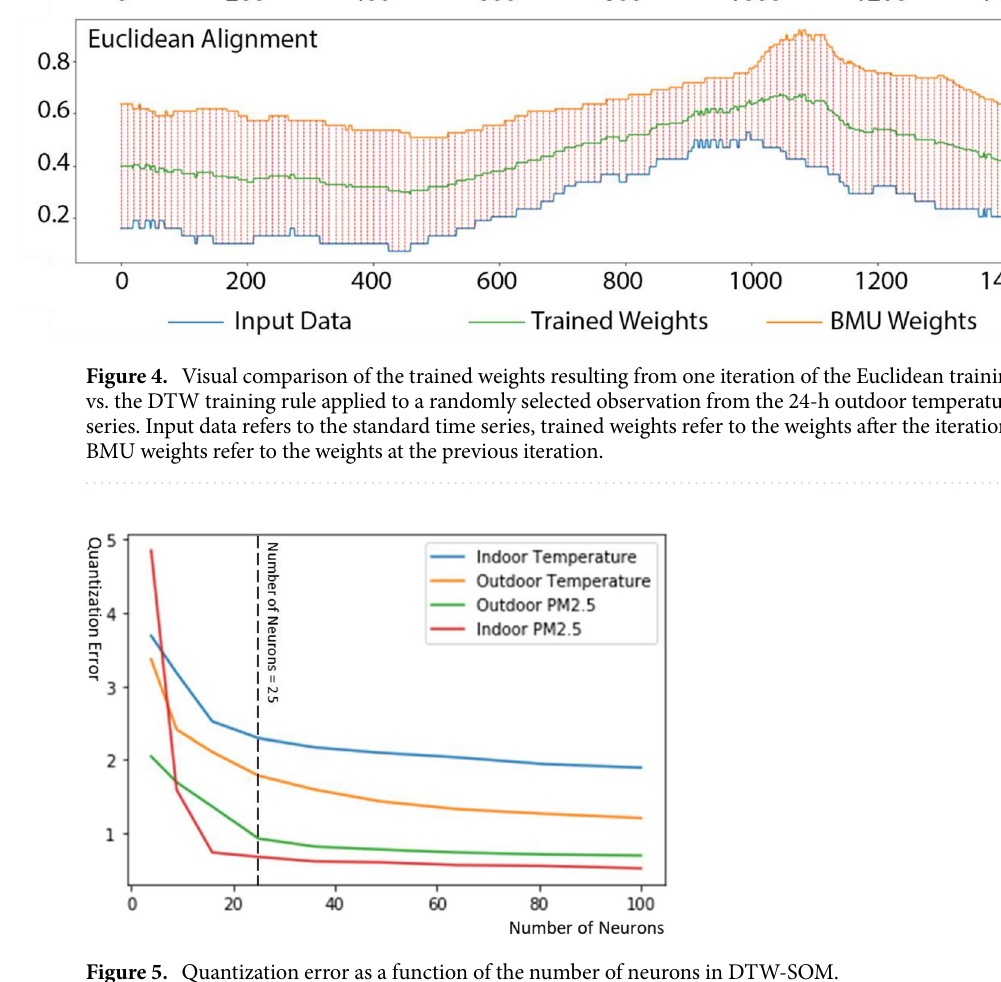
Figure 5. Quantization error as a function of the number of neurons in